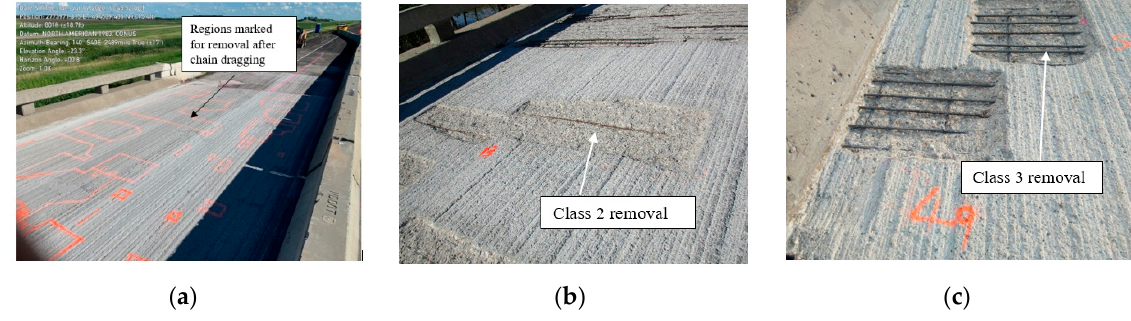
Figure 5. ( a ) Delaminated section markings for FR bridge deck ( b ) class 2 sub-surface delamination removal and ( c ) class 3 sub-surface delamination removal.